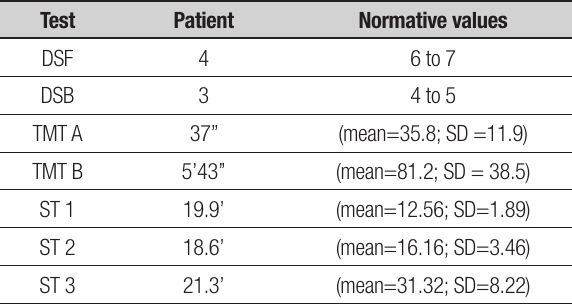
Table 2. Patient performance on executive function tests: